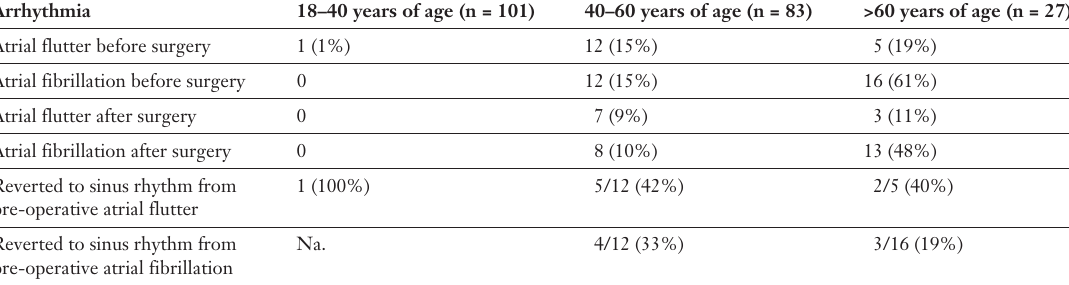
Incidence of arrhyth- mia before and after atrial septal defect closure and its re- gression in the Berlin study group Atrial fibrillation after surgery Reverted to sinus rhythm from Reverted to sinus rhythm from Na. 4/12 (33%) 3/16 (19%) pre-operative atrial fibrillation Na= Not applicable